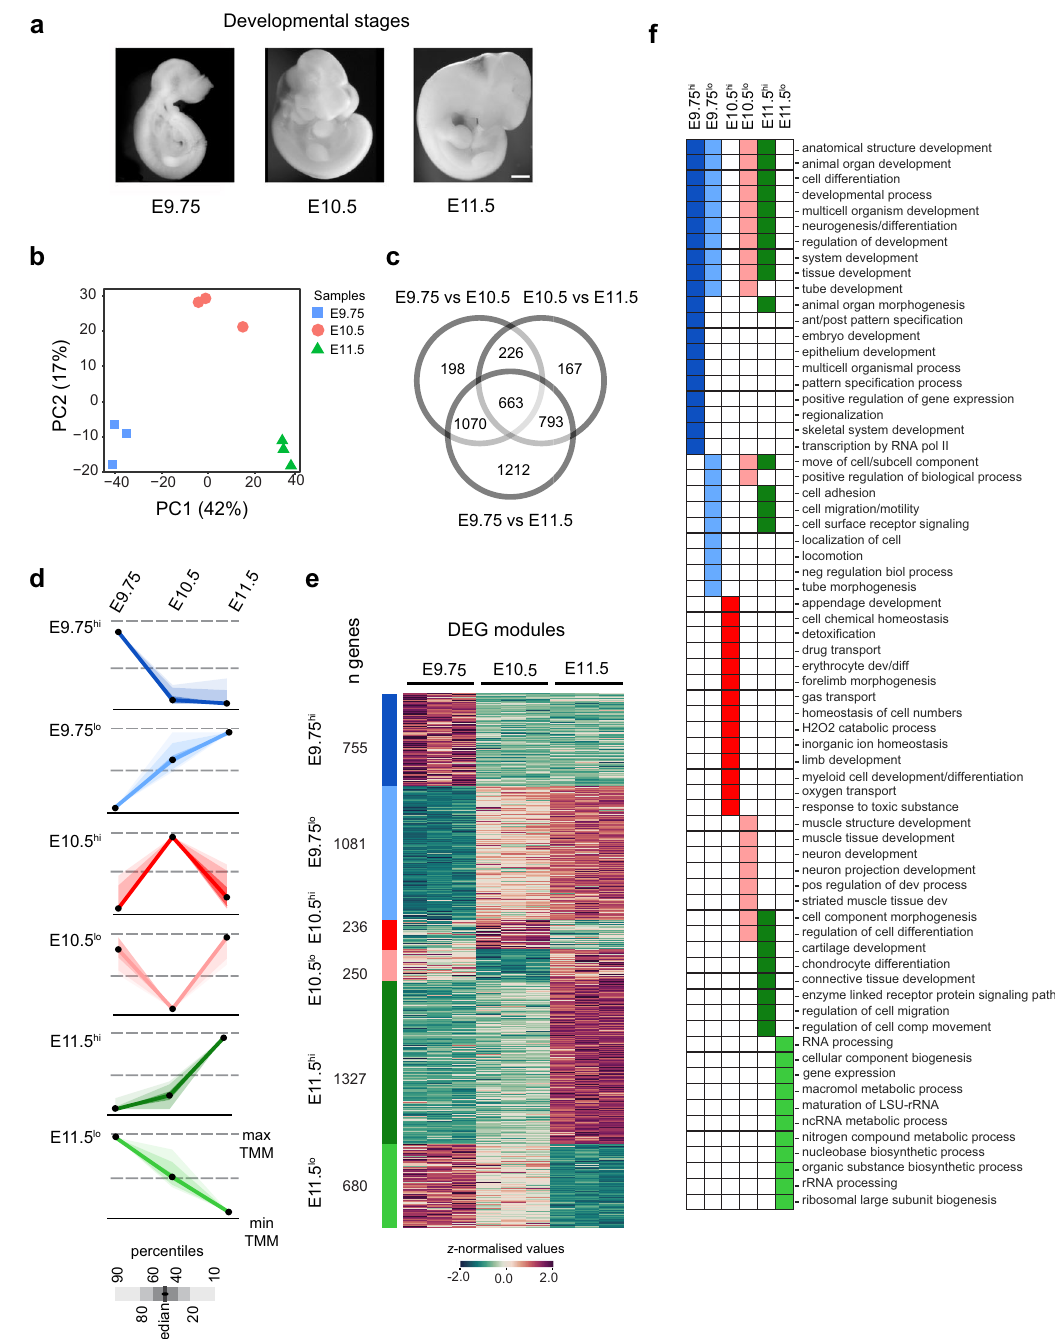
Fig. 1 Transcriptome pro fi ling of mouse forelimb bud identi fi es distinct temporal DEG modules. a Illustrations of mouse embryos at embryonic days E9.75, E10.5, and E11.5 that were used for the analysis of forelimb bud development (scale bar: 250 μ m). b Principal component analysis (PCA) of the RNA- seq samples of mouse forelimb buds (E9.75, E10.5, E11.5, n = 3 biological replicates per stage) were plotted as a function of the highly variable genes in PCA space. Genes were normalized using the Trimmed Mean of M-values (TMM) method of edgeR to carry out this analysis. The clustering of biological replicates ( n = 3) at the different stages points to minimal intra-sample variability. Samples are indicated by different colors and shapes. c Three-way Venn diagram illustrates the overlap of DEGs across different pairwise comparisons. d Scaled module pro fi les were derived using k-means clustering of DEGs. The six DEG modules with distinct expression pro fi les are indicated by a color code that is used for all subsequent analyses. Black dots represent the median values while the shaded areas correspond to the percentiles as indicated in the scale (below the graphs). e Heatmap of all DEGs ( n = 4329) illustrating relative gene expression across developmental stages. The DEGs were identi fi ed using the likelihood ratio test as implemented in glm function of edgeR. The adjustments were made for multiple comparisons using the Benjamini – Hochberg (BH) method. DEGs with signi fi cant changes in transcript levels must have a linear absolute FC cutoff of ≥ 1.5 and an adjusted p value ≤ 0.05. The z- score scale represents mean-subtracted regularized log- transformed read counts. The number of DEGs per module ( n ) is indicated. f The top enriched GO terms for each DEG module are shown. DEG differentially expressed genes, GO gene ontology. Source data are provided as a Source Data fi